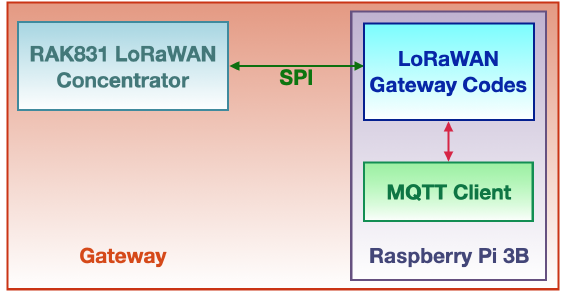
Figure 5. Gateway block